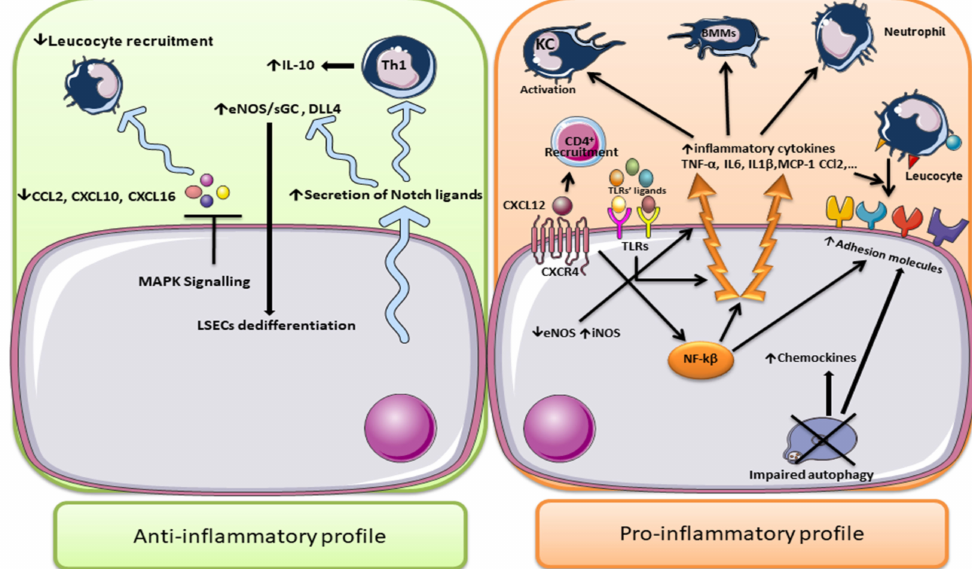
Figure 2. The LSECs’ anti-inflammatory and pro-inflammatory profiles during the progression of NAFLDAt the early stage of NAFLD, LSECs display an anti-inflammatory function characterized by a reduced expression of chemokines such as CCL2, CXCL10, and CXCL16 through MAPK signaling and an induced expression of IL-10 by Th1 cells through the activation of Notch signaling. The activation of Notch signaling manifests anti-inflammatory effects through the induction of eNOS/sGC levels.During the progression of NAFLD from simple steatosis to NASH and cirrhosis, LSECs exhibit a pro-inflammatory phenotype mediated mostly through the activation of the NF-kB pathway. NF-kB regulates the expression of adhesion molecules (VCAM-1, ICAM-1, E-selectin, and VAP-1) as well as the secretion of pro-inflammatory cytokines (TNF- α , IL-1, and IL-6). The secretion of inflammatory mediators is also regulated by TLRs and NO bioavailability. Elevated expression of adhesion molecules leads to induced leukocyte recruitment and their translocation into the hepatic parenchyma. On the other hand, increased expression of inflammatory mediators along with LSEC dysfunction stimulates the activation of KCs and leukocyte chemoattraction. The impaired LSEC autophagy observed during the progression of NAFLD also leads to the upregulation of adhesion molecule and chemokine expression, enhancing the inflammatory response. Reduced eNOS and increased iNOS contribute to the development of inflammation, the activation of KCs, and the recruitment of bone-marrow-derived macrophages. Abbreviations: ICAM-1: Intercellular adhesion molecule-1; IL-1: Interleukin 1; IL-6: Interleukin 6; LSECs: Liver sinusoidal endothelial cells; MCP1: Monocyte chemoattractant protein-1; NF-kB: Nuclear factor kappa B; NO: nitric oxide; TNFa: Tumor necrosis factor alpha; VAP-1: Vascular adhesion protein1; VCAM-1: Vascular cell adhesion molecule-1; BMMs: bone-marrow-derived macrophages; TLR: Toll-like receptor; CXCL12: C-X-C motif chemokine ligand 12; CXCR4: C-X-C chemokine receptor type 4; KC: Kupffer cells. This image was derived